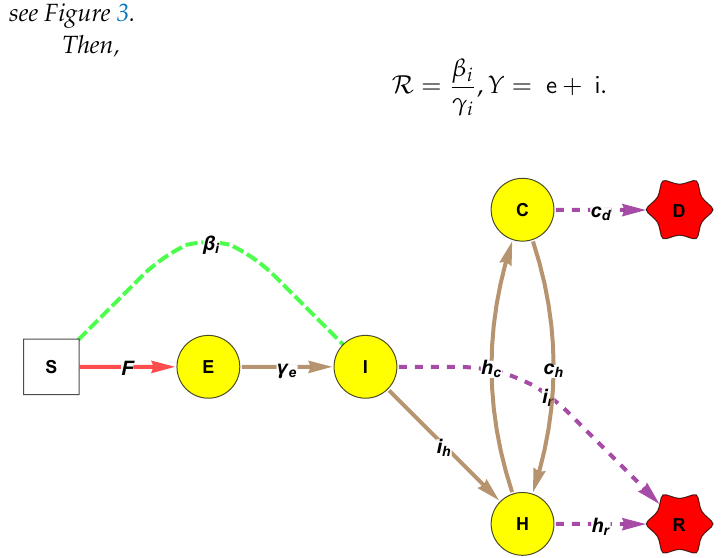
Figure 3. Flowchart of SEIHCRD model. The force of infection is F = β i i .